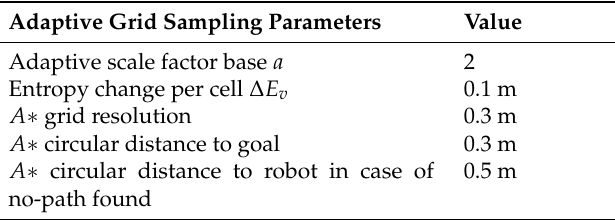
Table 3. Adaptive Grid Sampling Approach Parameters.